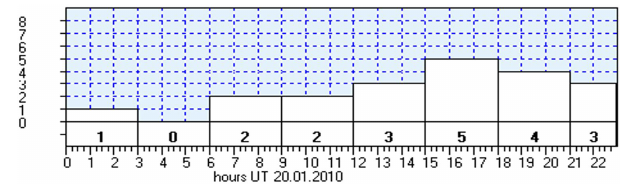
Figure 6. Values of Kp index on 20 January 2010.